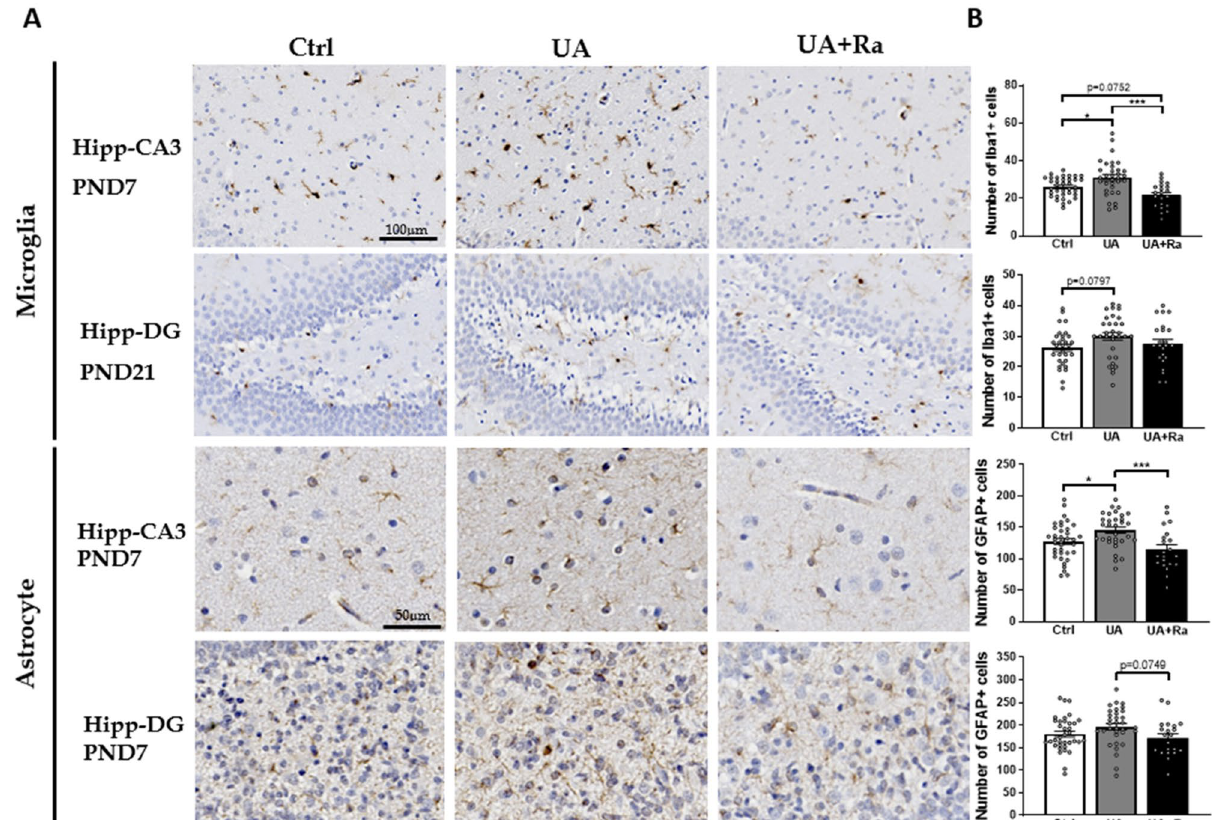
Figure 4. Histological analysis of Iba-1 and GFAP positive cell in the hippocampus following uric acid alone or with IL-1Ra prenatal treatment at PND7. Injection of uric acid during gestation increased the number of microglia and astrocytes in the hippocampus (CA3) at PND7. Prenatal treatment with IL-1Ra prevented the microgliosis and astrogliosis observed at PND7. Representative image shown in ( A ) and quantification in ( B ). N = 8–16 litters (i.e. PBS = 11; IL-1Ra = 8; UA = 16; UA + Ra = 12). *p < 0.05; ***p < 0.001 Results presented as mean ± SEM. Statistical analysis by one-way ANOVA with Tukey’s multiple comparisons test with GraphPad Prism 9.2.0 (GraphPad Software, CA); www. graph pad. com.